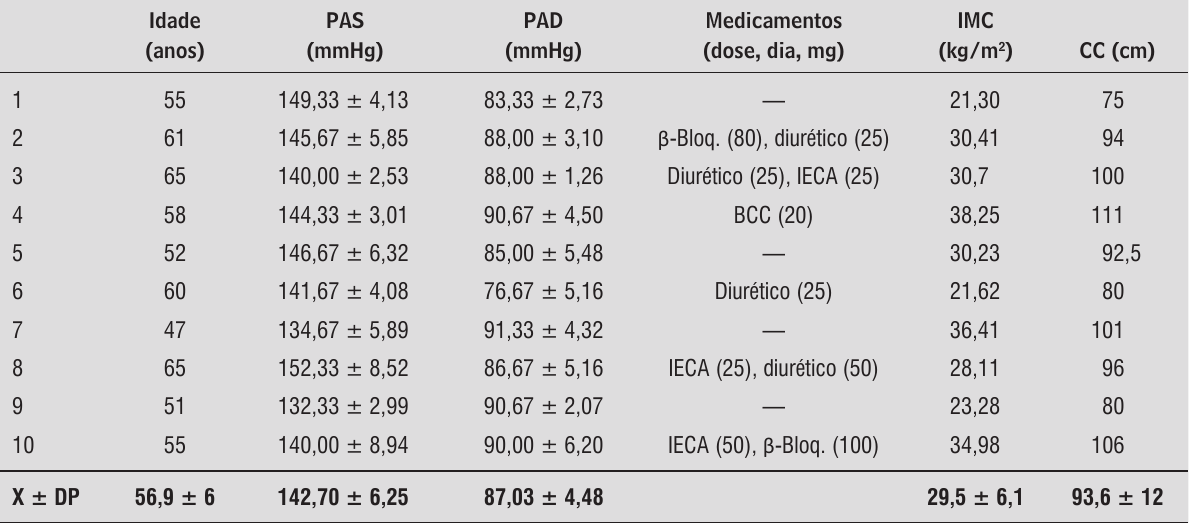
Legenda: PAS = pressão arterial sistólica; PAD = pressão arterial diastólica; mmHg = milímetro de mercúrio; IMC = índice de massa corporal; CC = circunferência da cintura; IECA = inibidor da enzima conversora de angiotensina; β -Bloq. = betabloqueador; BCC = bloquea-